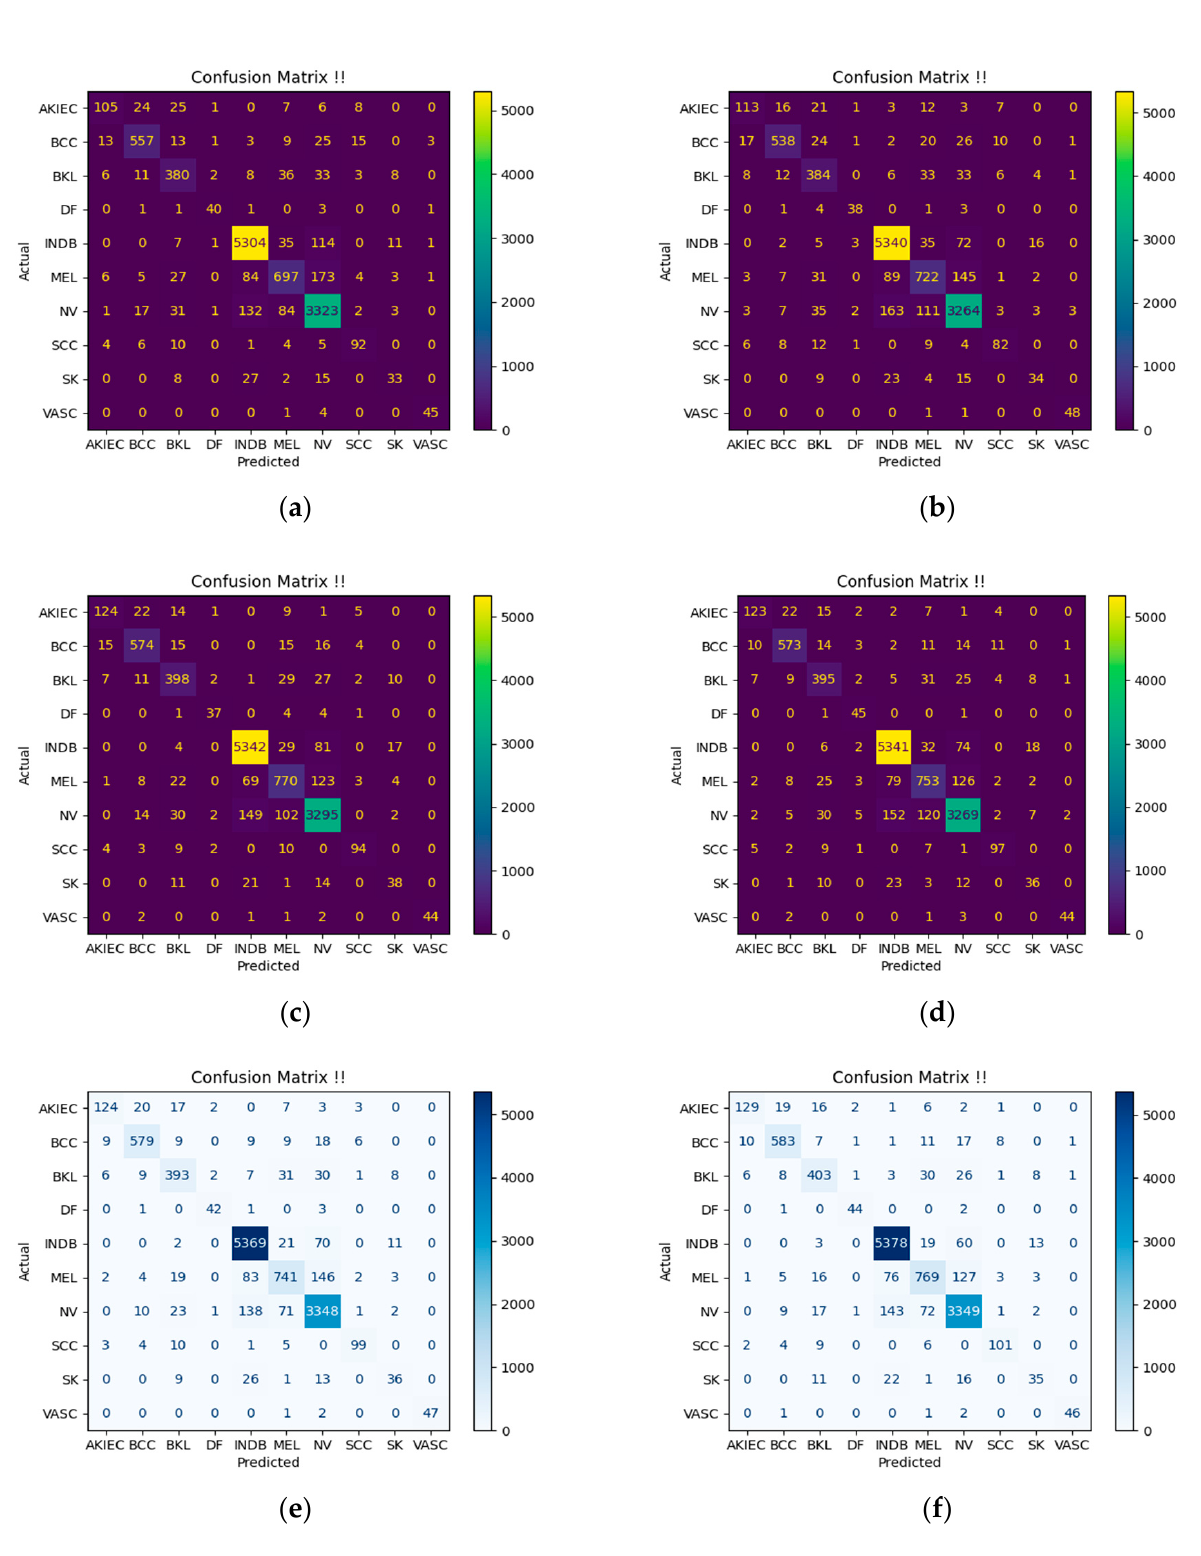
Figure 4. Confusion Matrices. ( a ) DPN-131 [60]; ( b ) ECA-ResNet-101 [61]; ( c ) IG-ResNeXt-101 [62]; ( d ) SWSL-ResNeXt-101 [63]; ( e ) Simple Majority Voting Ensemble; ( f ) Weighted Majority Voting Ensemble.